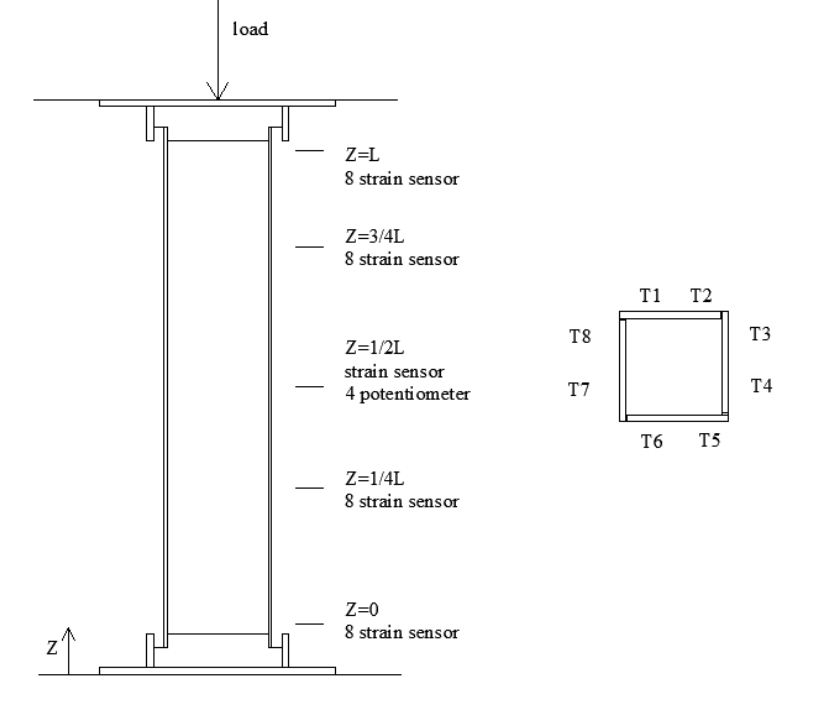
Fig. 4 Position of the strain sensors and potentiometers.